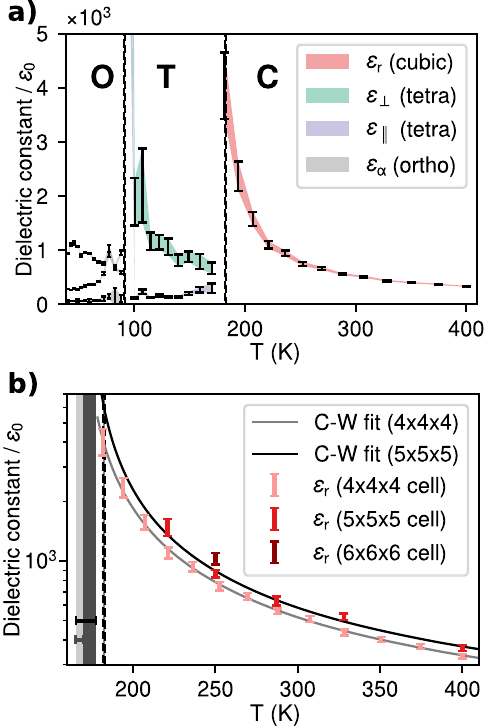
Fig. 7 Static dielectric constant of BaTiO 3 . a Temperature depen- dence of the static dielectric constant computed for a 4 × 4 × 4 supercell across the orthorhombic, tetragonal, and cubic phases. The phase transition temperatures computed from the chemical potential (see Table 1 are shown as vertical dashed lines. b Supercell-size comparison of dielectric constants computed in the cubic phase, including fi ts to the Curie – Weiss law Equation (5) — note the log scale on the y -axis. The effective Curie temperature T c, ε predicted by each fi t is shown by the shaded vertical spans and the error bars towards the bottom left of the fi gure. Error bars show one standard deviation and are computed as described in Supplemen- tary Note